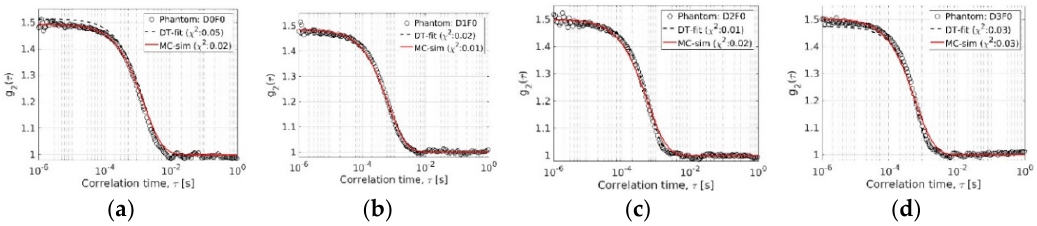
Figure 11. DCS measurements (symbols) for phantoms D 0 F 0 − D 3 F 0 , ( a – d , respectively) with theoretical fits using a Brownian-flow model (dashed line) and MC predictions (solid line). Each MC model used input D B values obtained from scaling the theoretically fitted values (see text). Table2. InputcoefficientsforMCflowphantommodels. ∆ h wasconstrainedtobe0.03cmexperimentally while the relative change in fluid flow speed from flow rate of F 1 to F 2 was 2.5 (change from F 1 to F 3 was